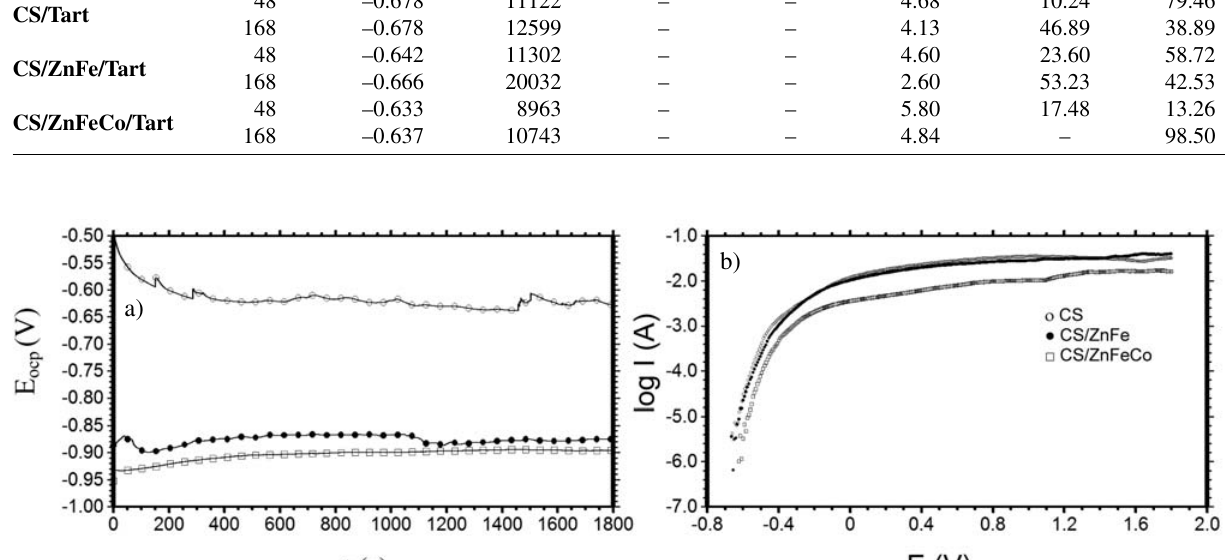
= 170 mV dec –1 for bare carbon steel electrode a